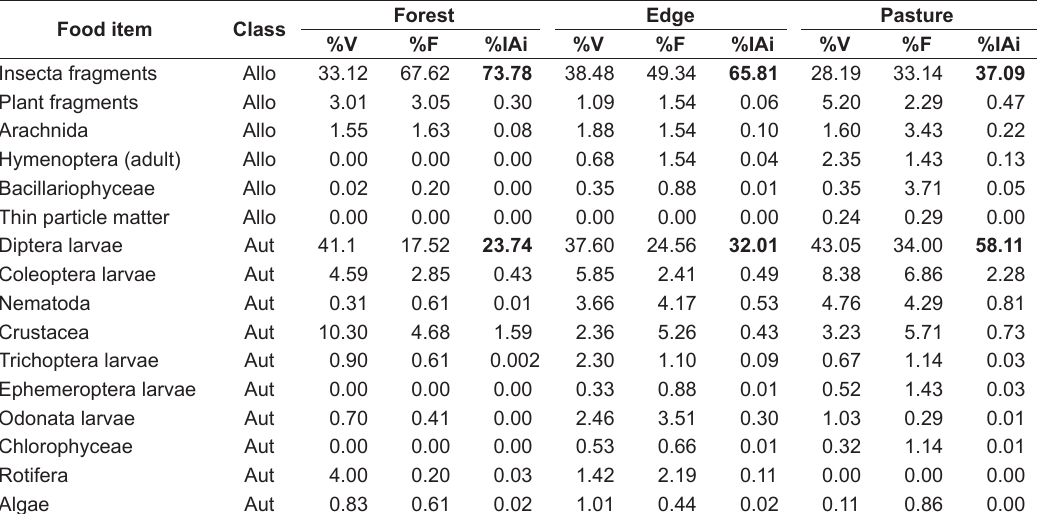
Table 1. Composition of stomach contents of Apistogramma agassizii individuals from the forest, edge, and pasture areas. Food